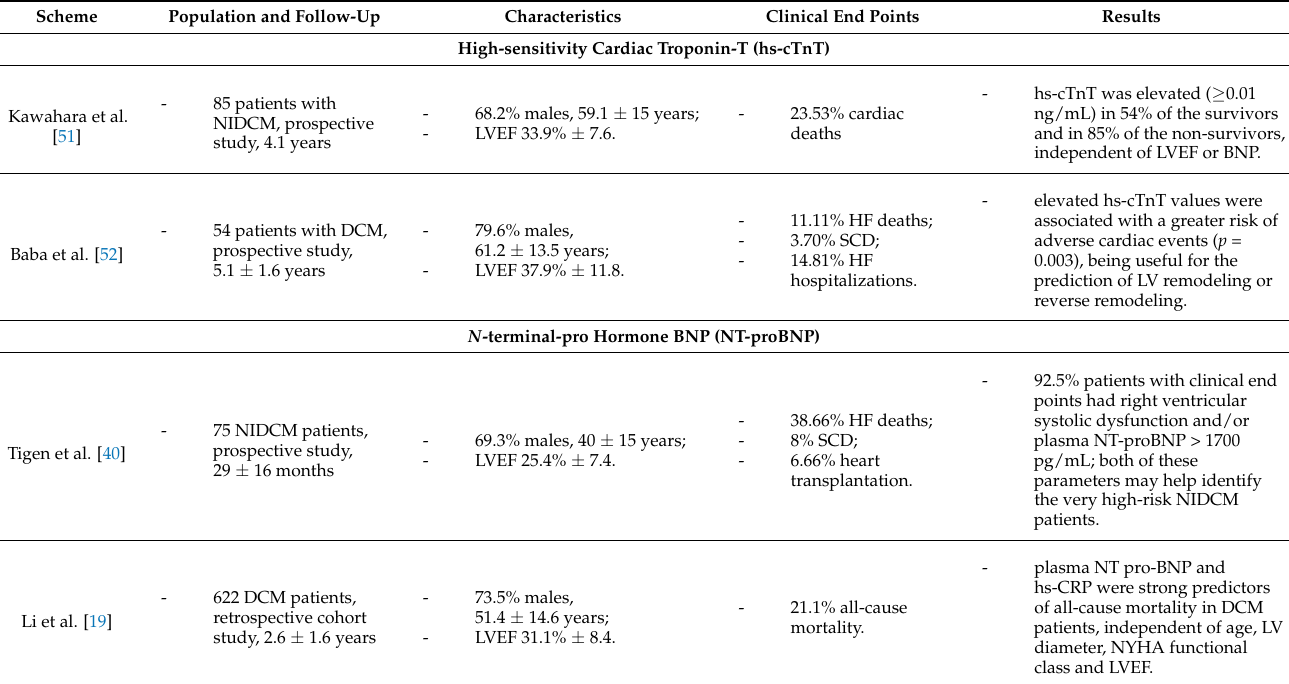
Table 1. Studies relating well-known biomarkers for risk stratification in dilated